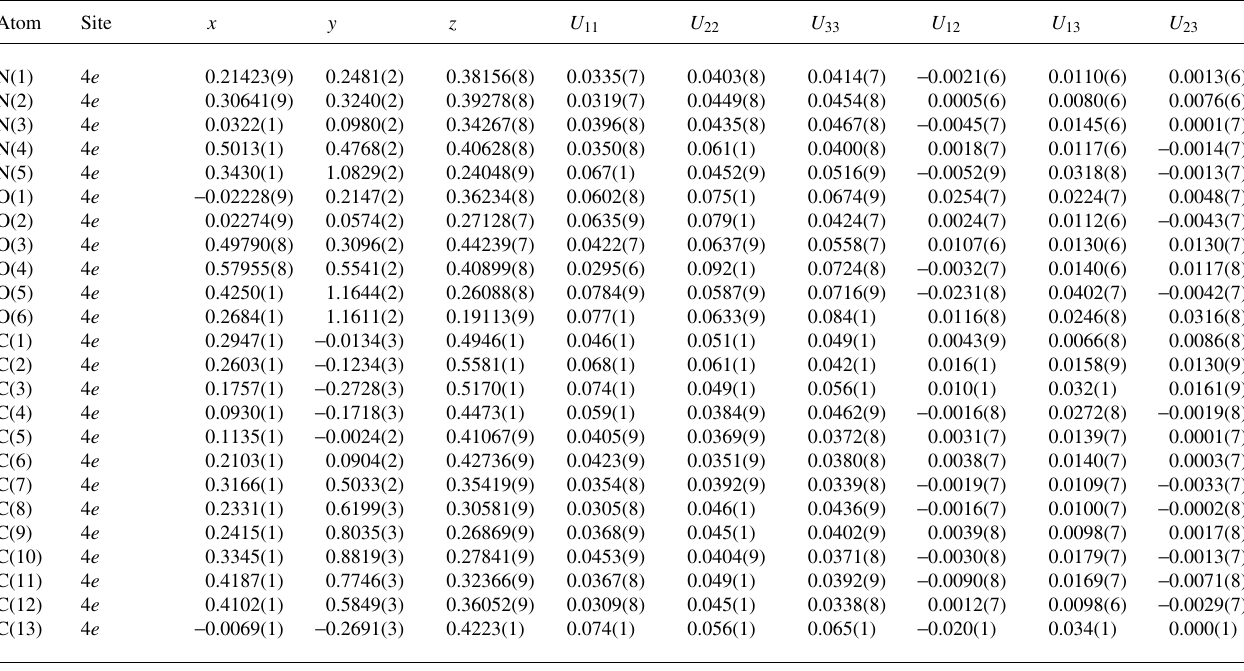
Table 3. Atomic coordinates and displacement parameters (in Å 2 ) .